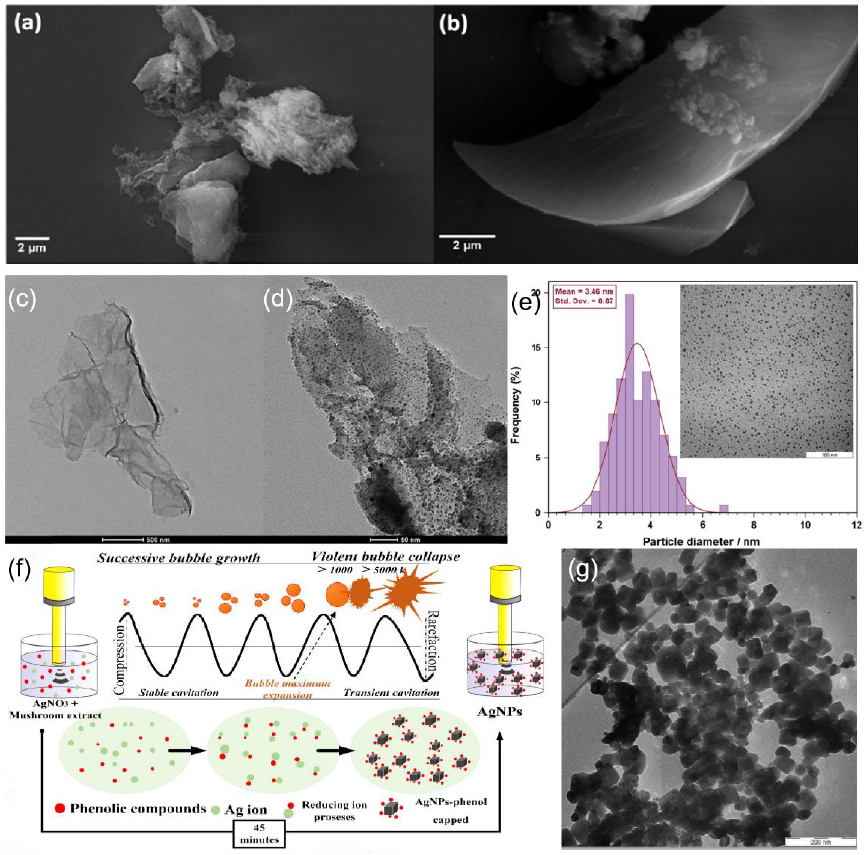
Figure 7. SEM micrographs of ( a ) GO and ( b ) GO-Ag nanocomposite and ( c ) EDX of GO-Ag nano-